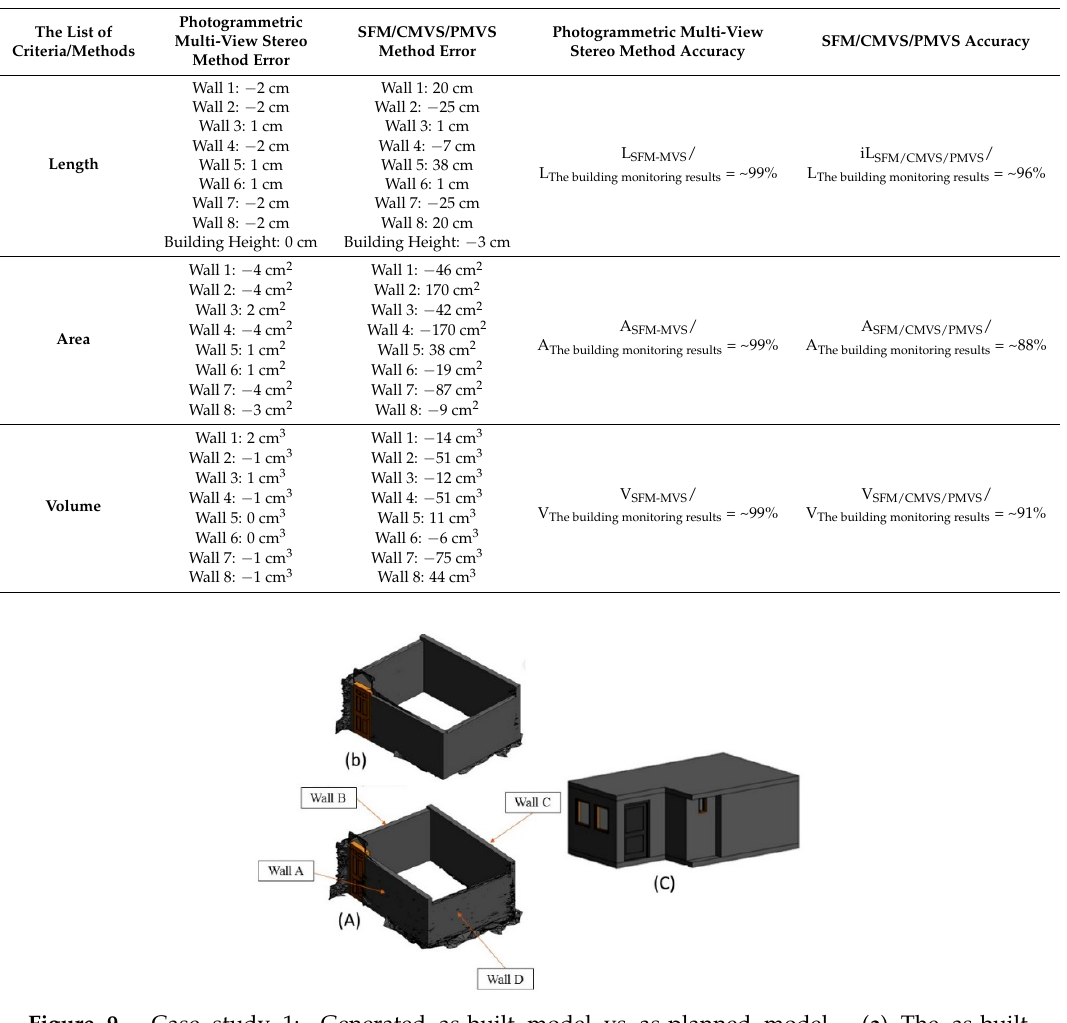
Table 6. Comparing the accuracy of as-built models generated by the proposed photogrammetric Multi-View Stereo method and SFM/CMVS/PMVS algorithm (case study 2).